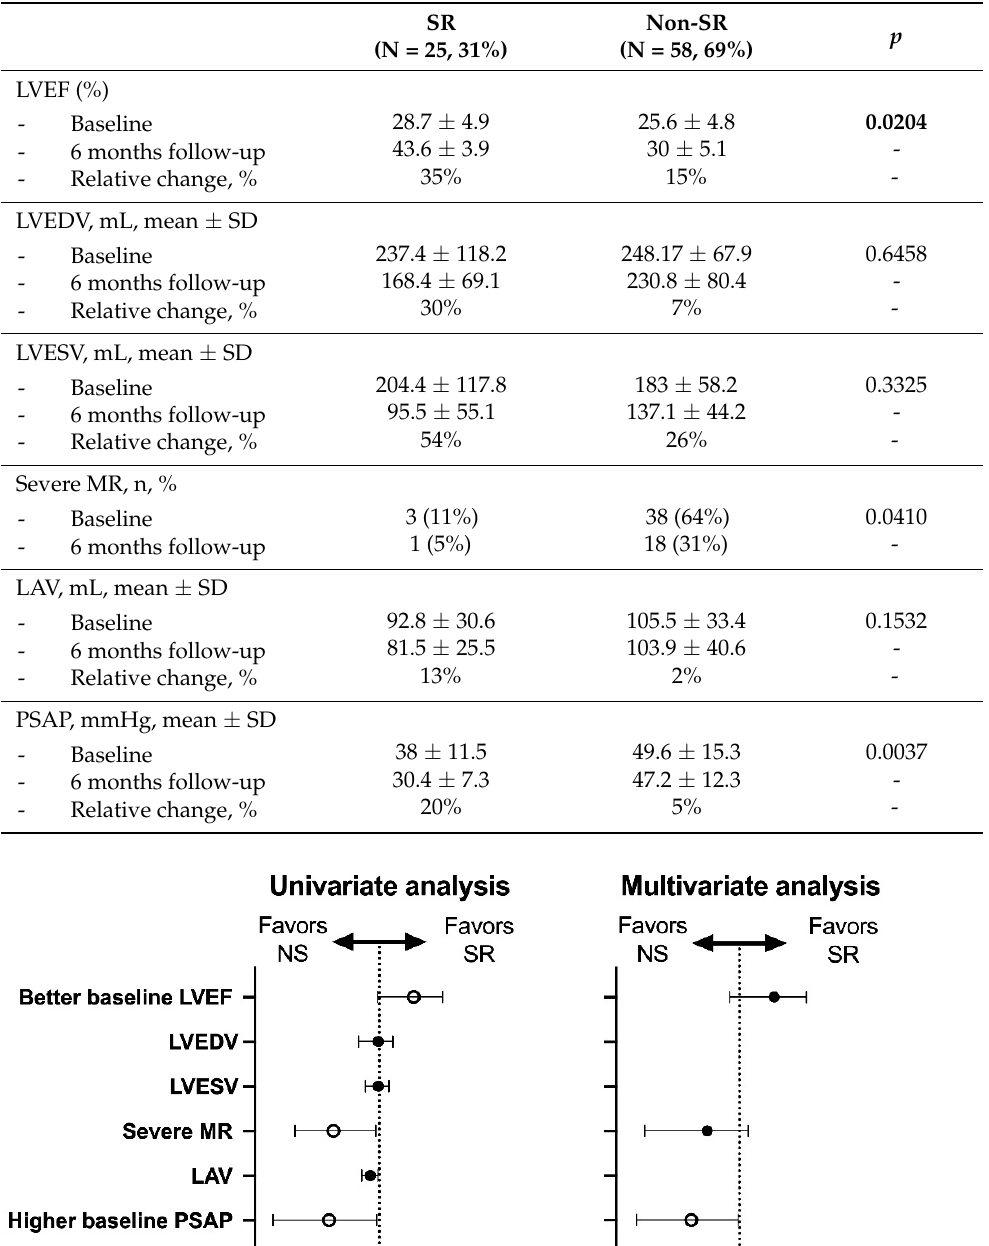
Table 3. Echocardiography parameters in SR versus non-SR groups.